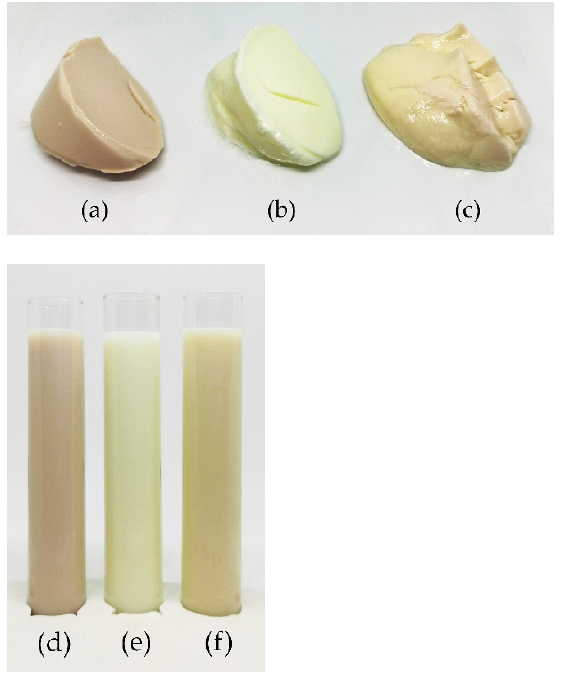
Figure 8. Photographs of the fermented samples, ( a ) lentil, ( b ) dairy, ( c ) soy and non-fermented